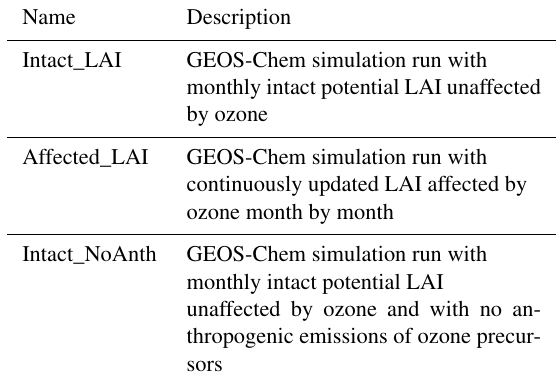
Table 2. GEOS-Chem experiments to investigate the effect of syn- chronous ozone–vegetation